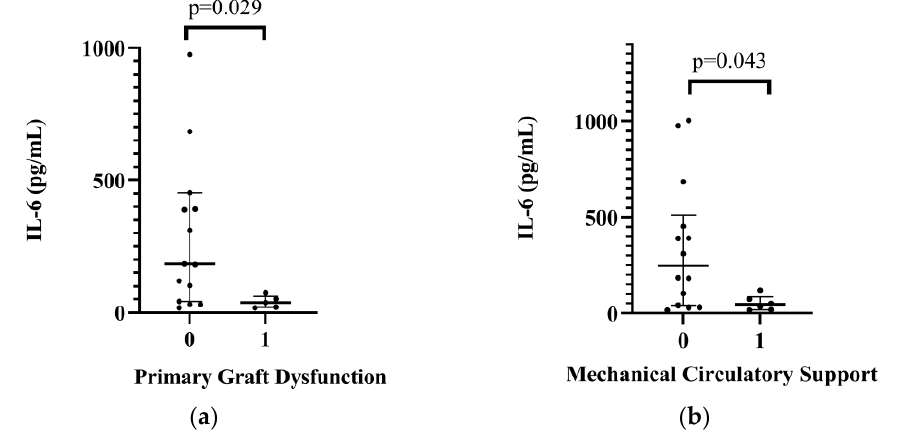
Figure 1. ( a ) Relationship between donor’s pericardial interleukin-6 levels (IL-6) and primary graft dysfunction after heart transplant. ( b ) Relationship between donor’s pericardial interleukin-6 levels (IL-6) and postoperative mechanical circulatory support after heart transplant.